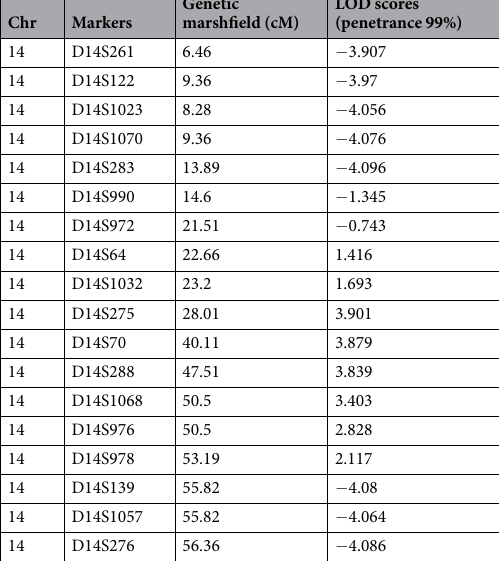
Table 2. Log odds scores of microsatellite markers in chromosome 14. Abbreviations: Chr, chromosome; cM, centi